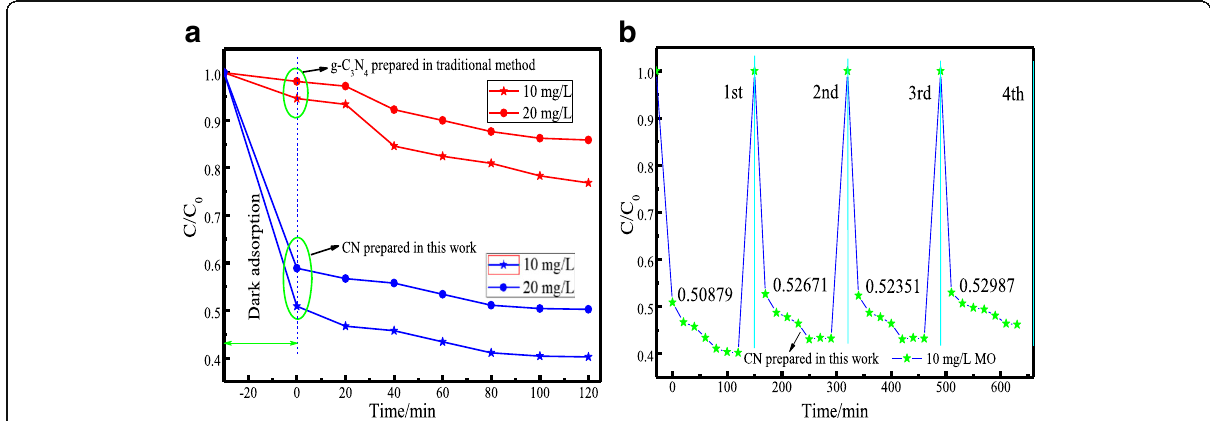
Fig. 6 a Comparison of photoactivity between CN and g-C 3 N 4 and b recycling degradation experiments of